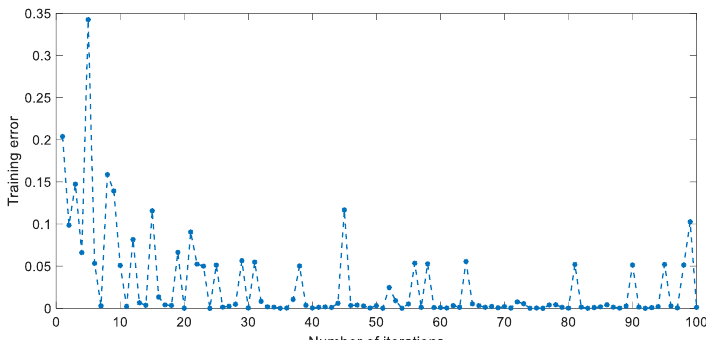
Figure 13. The converging curve of GCA-CNN on the Flevoland image.